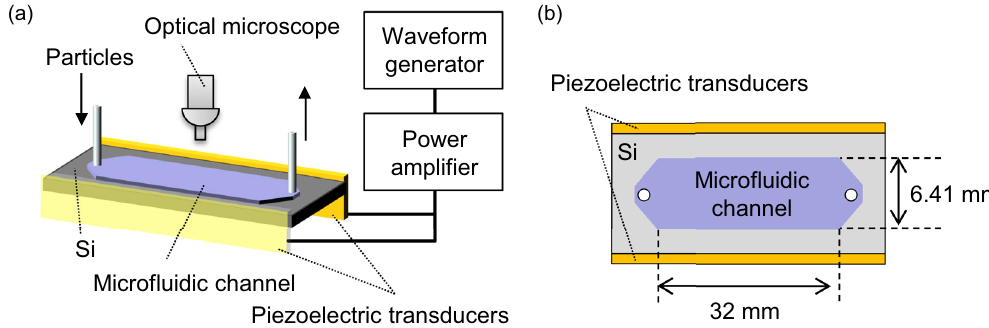
Figure 7. ( a ) Overview of measurement setup. ( b ) Top view of the